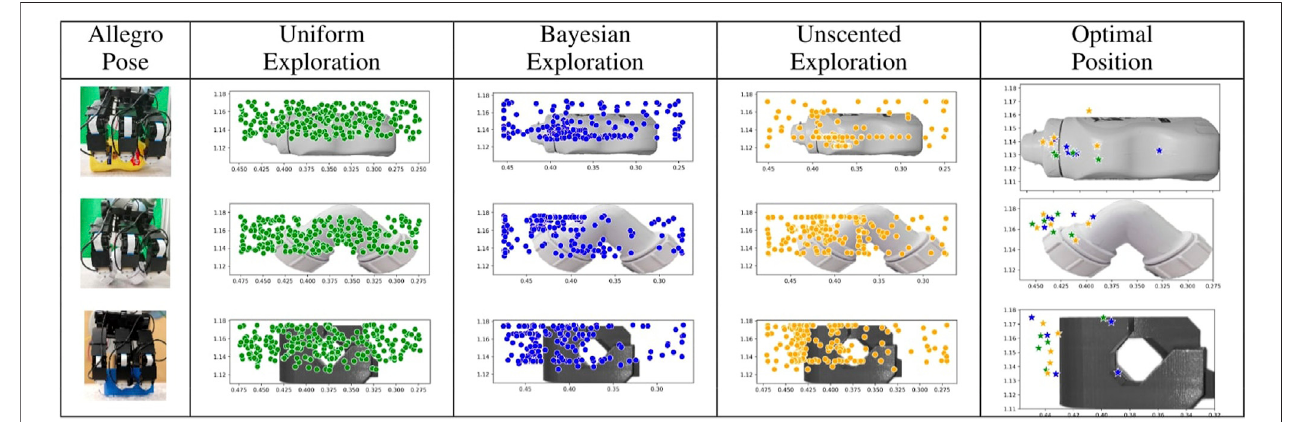
FIGURE3| ScatterPlotsofallpointsexploredinuniform,BOandUBOexplorationsfor (A) bottle, (B) pipejointand (C) blueobject.TheposeofAllegrohandatthe start of experiments is shown in the fi rst column. The last column represents the optimum position in 2D from each